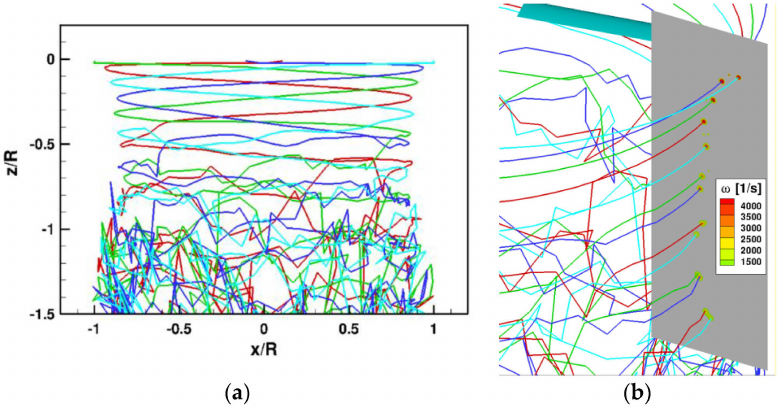
Figure 15. Blade tip trajectories ( a ), Numerical vorticity in the PIV plane and association with the generator vortex filaments ( b